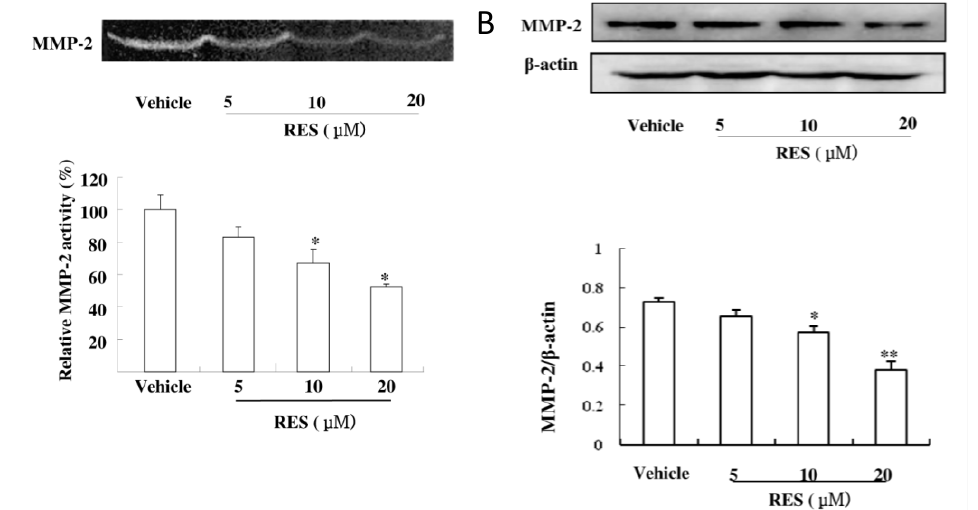
Figure 4. RES suppresses the activity and expression of MMP-2 in GICs. ( A ) GICs (412) were treated with DMSO (vehicle) and 5 μM, 10 μM, and 20 μM RES for 48 h, respectively. The activity of MMP-2 was assessed using the concentrated conditioned medium (CM) by gelatin zymography; ( B ) Cell lysates were subjected to western blotting with anti-MMP-2 antibody to evaluate the protein expression of MMP-2. β-actin was used as a loading control. * p < 0.05, ** p < 0.01, vs.